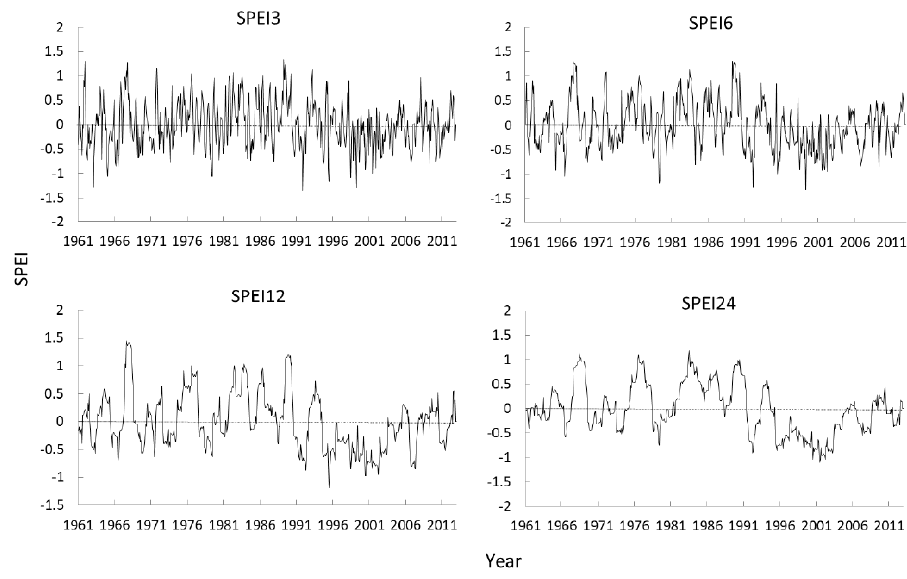
Figure 3. Dynamic characteristics of SPEI at multiple time scales in Qinghai Province.